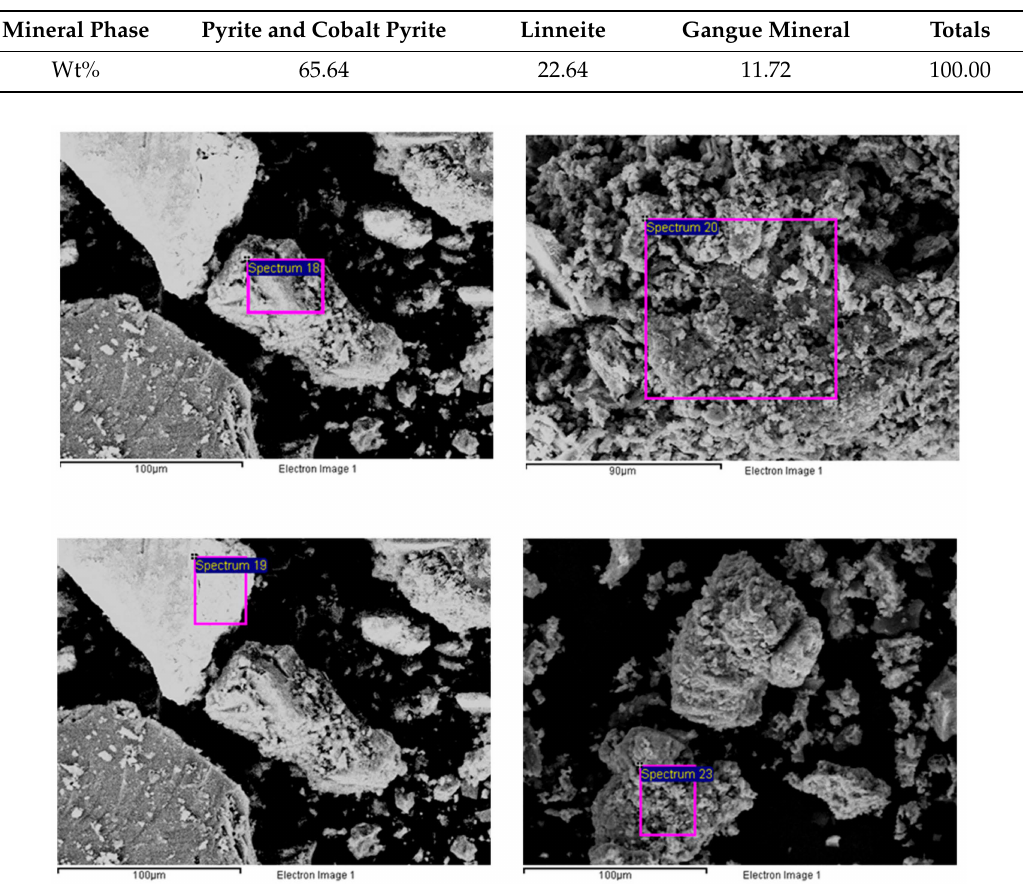
Figure 14. SEM analysis images of cobalt–sulfur